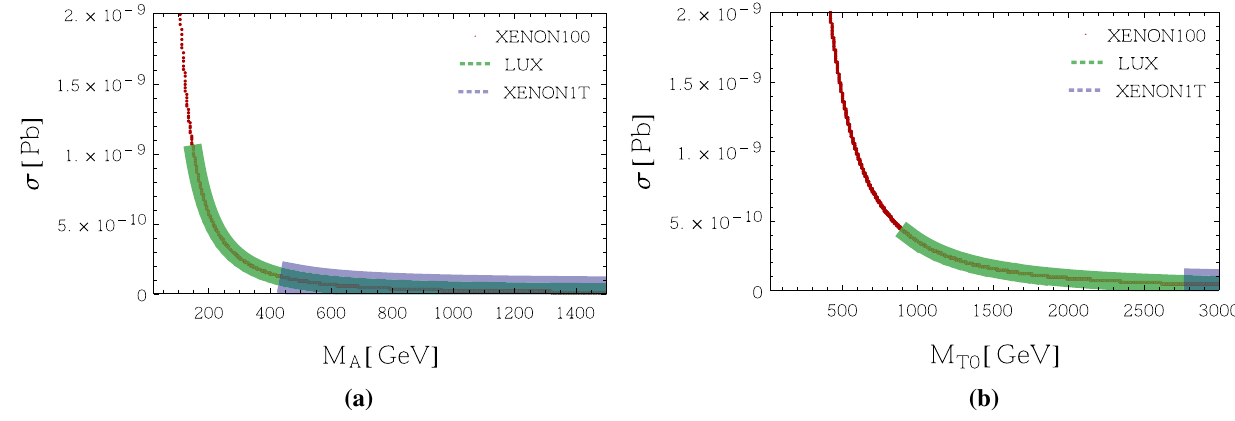
Fig. 11 SI cross-section verses dark matter mass in GeV. Here we have shown XENON100, LUX and XENON1T data in red, green and blue regions respectively. Widths in green and blue regions are to make them transparent such that other bounds are